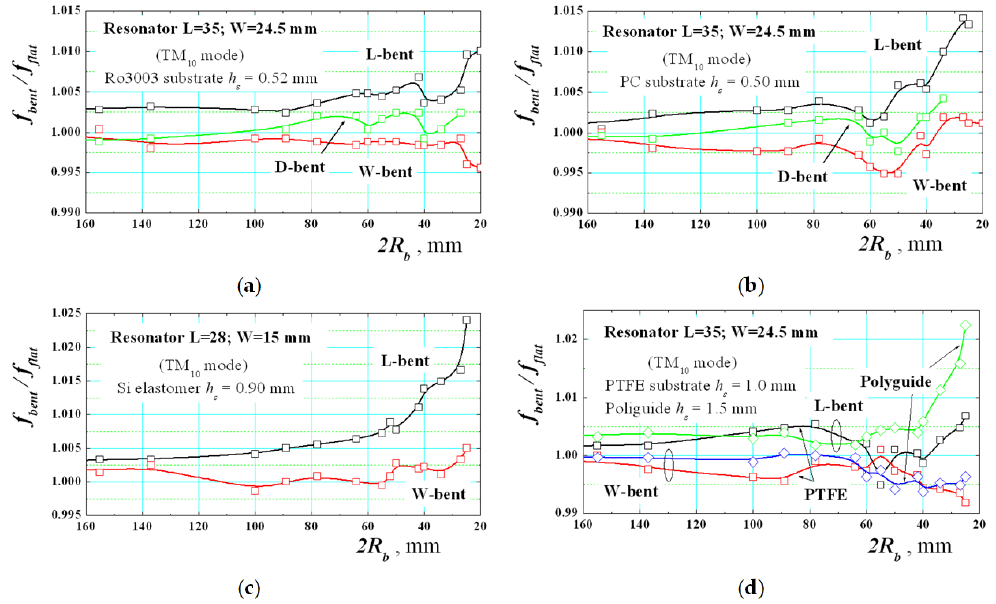
Figure 13. Experimental dependencies of the ratio between the resonance frequencies f bent / f flat of the lowest-order TM 10 mode for bent and flat rectangular resonators on several isotropic substrates versus the bending radius R b : ( a ) Ro3003; ( b ) PC; ( c ) commercial silicone elastomer; ( d ) PTFE and Polyguide ® Polyflon (http://www.polyflon.com; dielectric parameters 2.05/0.00045).